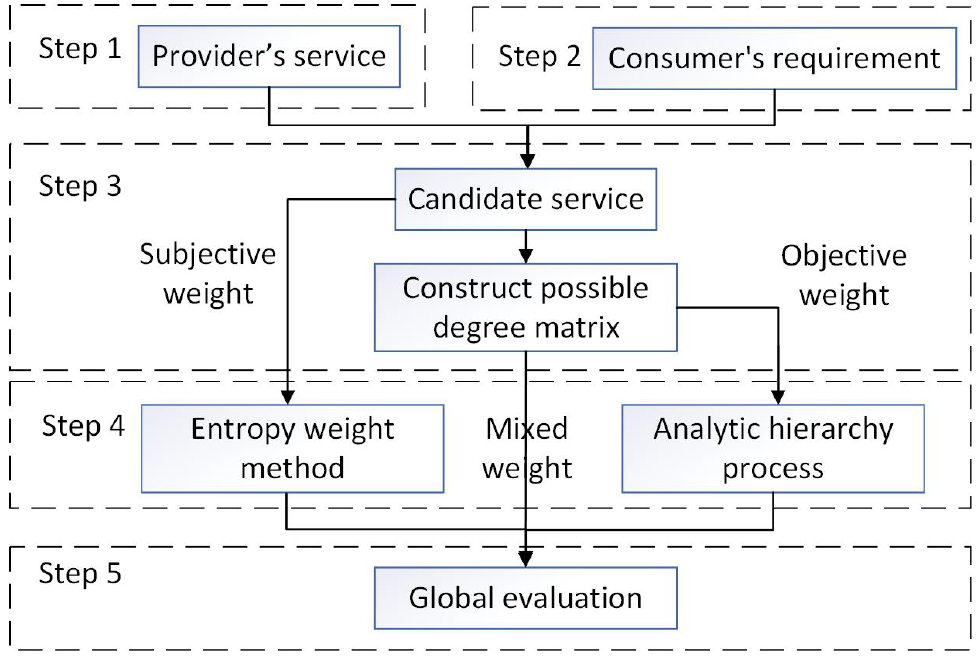
Figure 3. Global evaluation